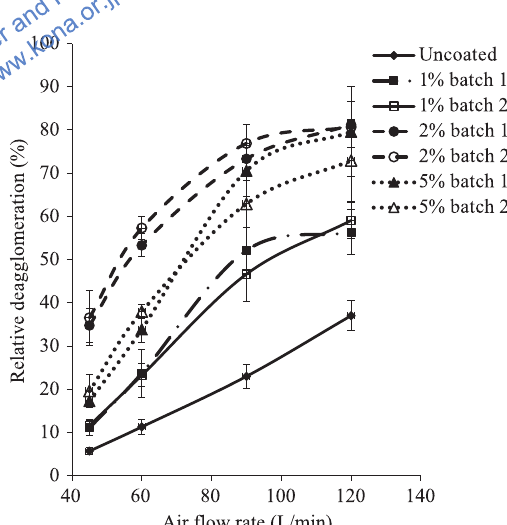
Fig. 2 The percent relative de-agglomeration versus air flow rate profiles for uncoated and two batches of 1 %, 2 % and 5 % magnesium stearate (MgSt) coated salbutamol sulphate dispersed from Rotahaler ® and determined using laser diffraction particle sizing of aerosol plume (Malvern Spraytec ® ) at flow rates of 45, 60, 90 and 120 L/min. ( n = 5, data represent mean ± standard